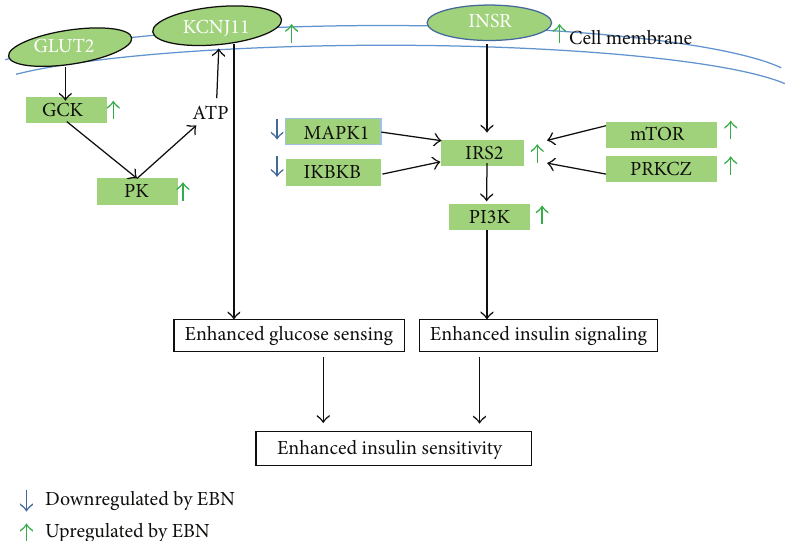
Figure 8: Proposed schematic showing targets of edible bird’s nest (EBN) action in the insulin signaling pathway. EBN prevents insulin resistance in high fat diet rats by influencing the transcriptional regulation of multiple